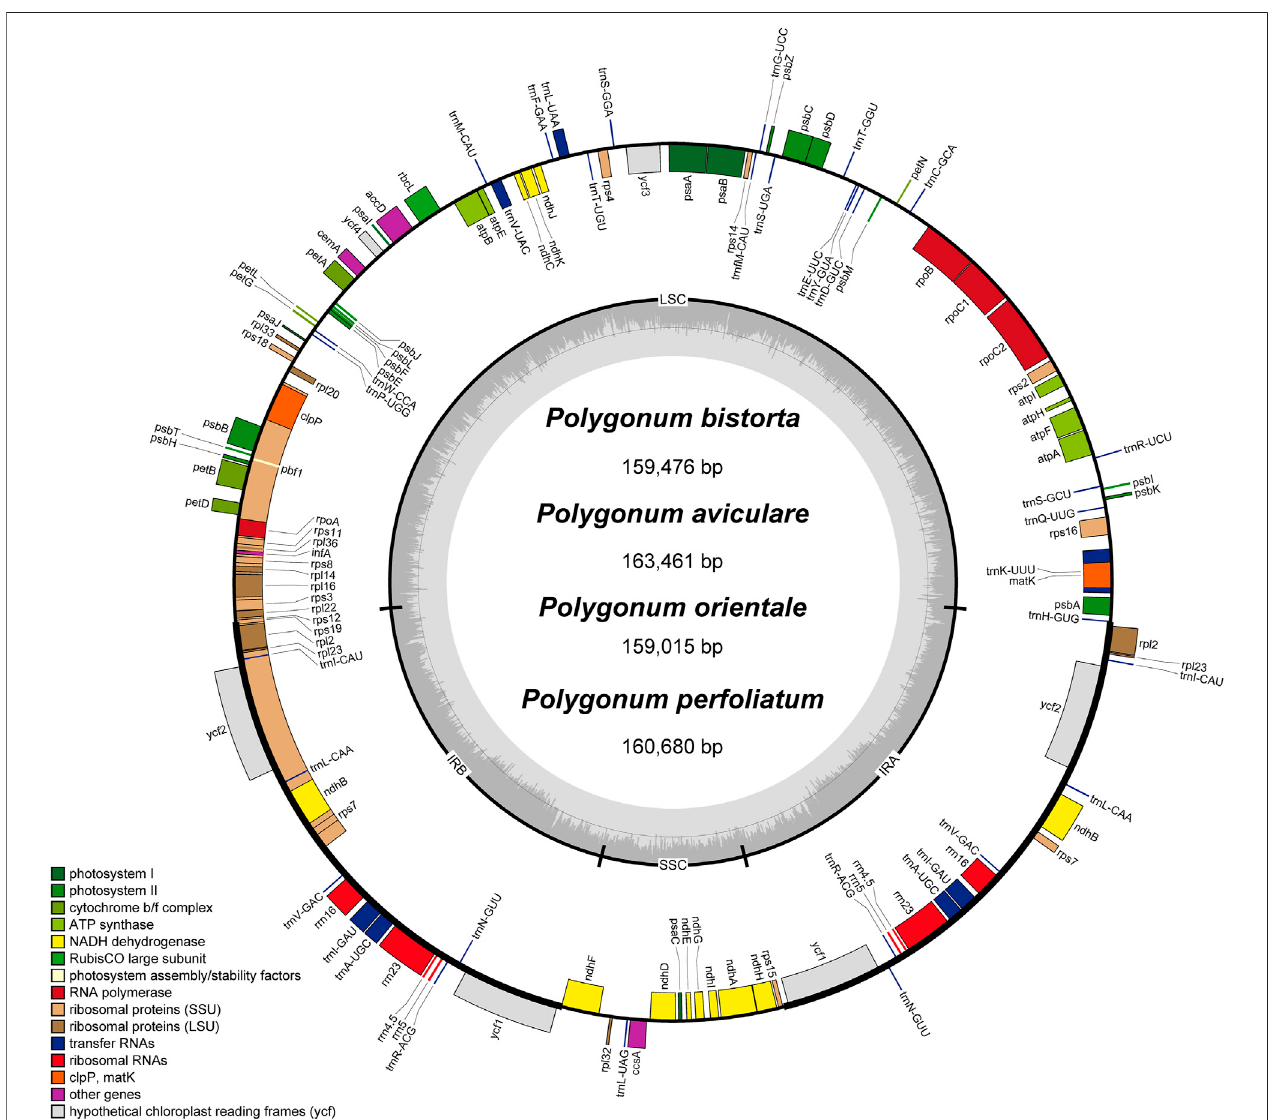
FIGURE 1 | Gene map of the Polygonum chloroplast genome. Genes drawn inside the circle are transcribed clockwise, and those outside are transcribed counterclockwise.Genesbelongingtodifferentfunctionalgroupsarecolorcoded.ThedarkergrayintheinnercirclecorrespondstoDNAG+Ccontent,whilethelighter gray corresponds to A + T